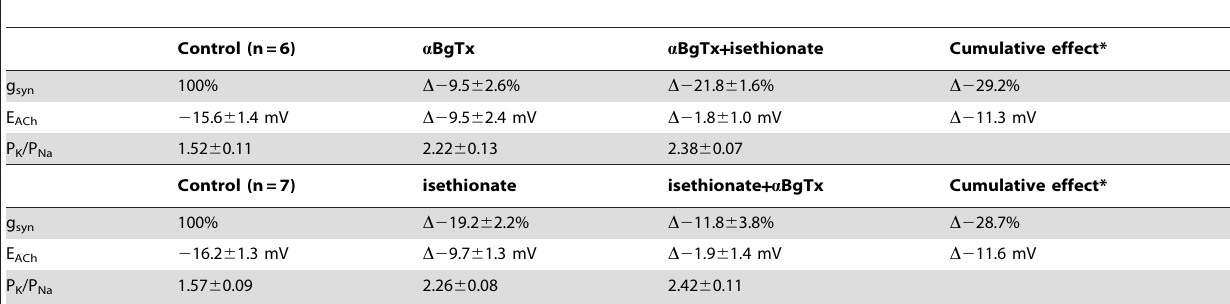
Table 1. Modifications of E ACh , g syn and the permeability ratio P K /P Na after subsequent application, in either order, of 200 nM a BgTx and 136 mM isethionate (substituting for an isoosmotic amount of NaCl).